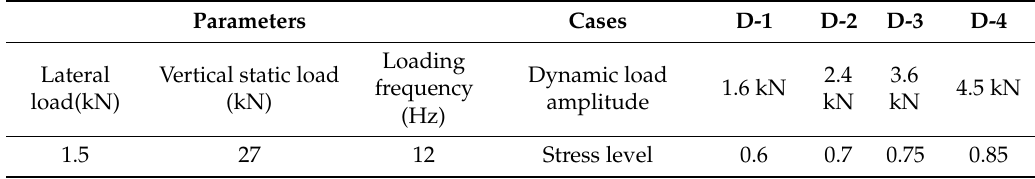
Table 6. Case for different levels of dynamic load (dynamic stress amplitude).